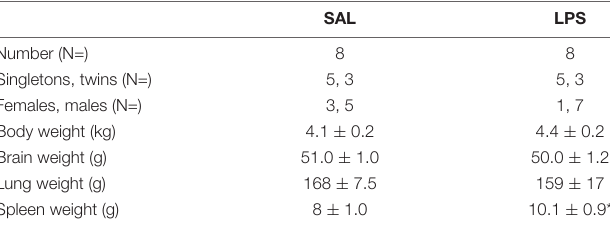
immunolabelling appears to be expressed in both neurons and glia. Double-immunolabeling showed co-localization of PGE 2 with GFAP + astrocytes within the preBÖTC ( Figures 4F,F’